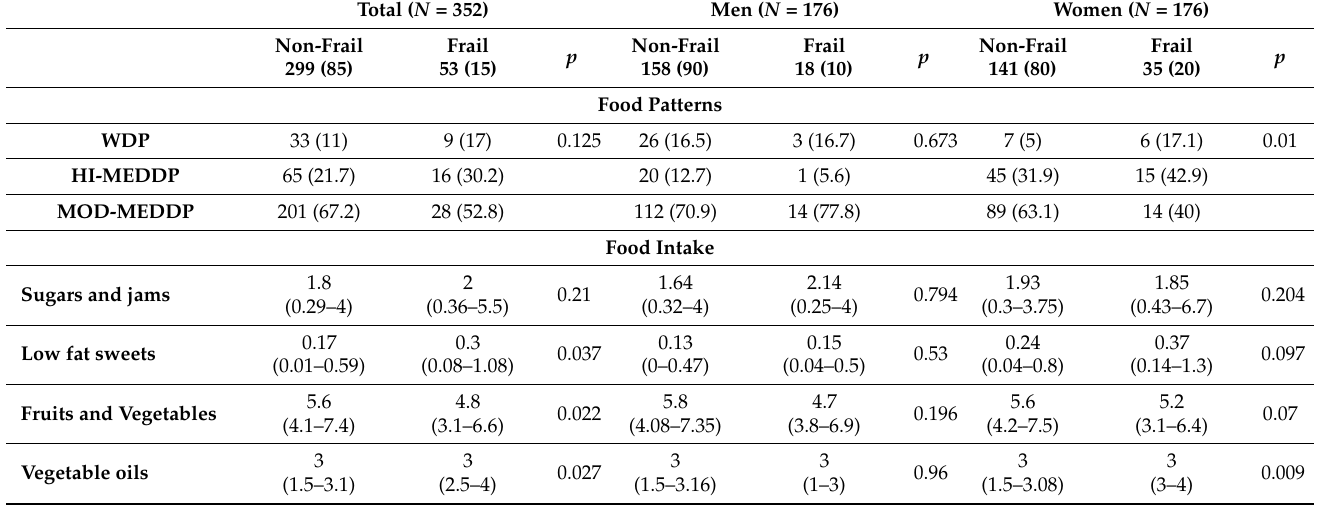
Table 4. Dietary patterns, food, and nutrient intake associated with frailty in the total sample and stratified by